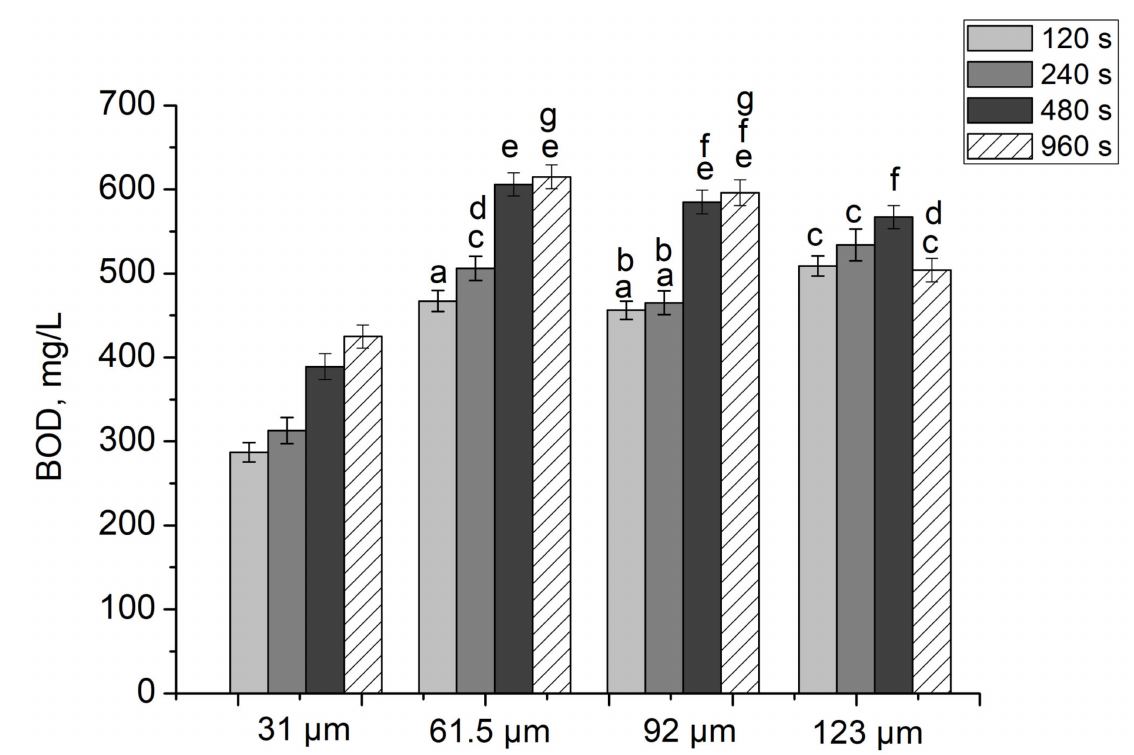
Figure 3. Effect of sonication time and the magnitude of the vibration amplitude on the BOD 5 value of coke wastewater (Statistical group